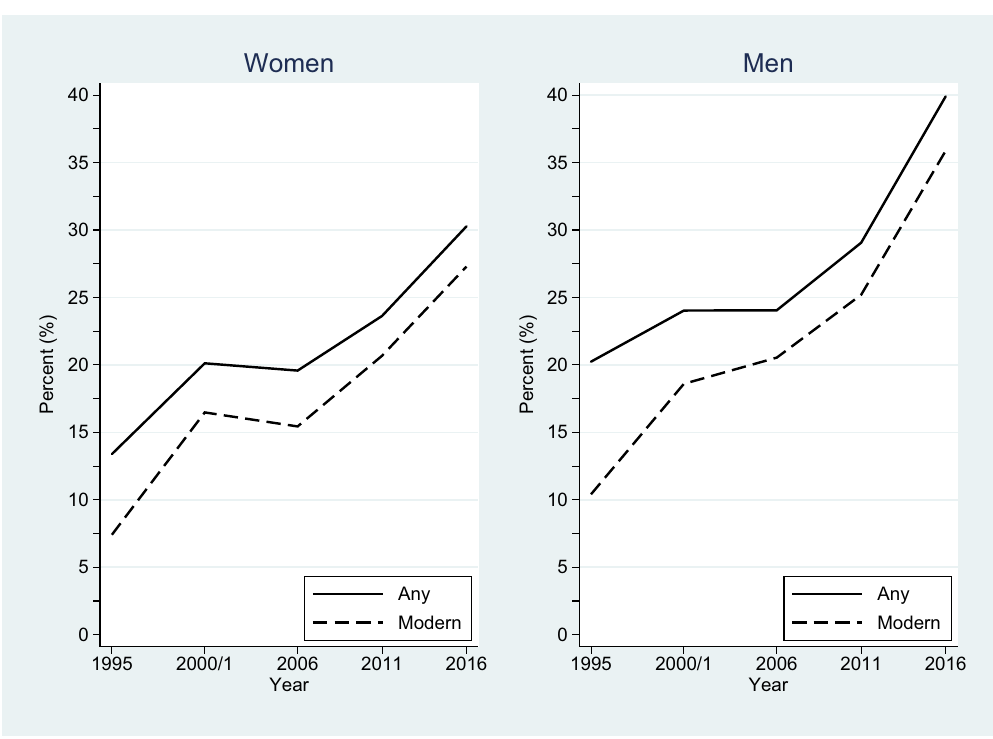
Fig 1. Changes in any and modern contraceptive use among women and men in Uganda across the study period (1995– 2016).